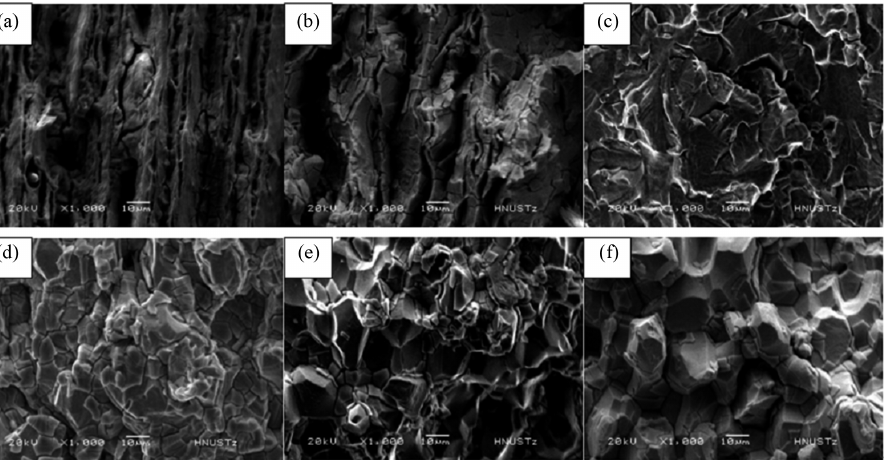
Figure 7: Tensile fracture topography of pure molybdenum after different temperatures of annealing (a) unannealing; (b) 800°C; (c) 1,000°C; (d) 1,100°C; (e) 1,200°C; (f)